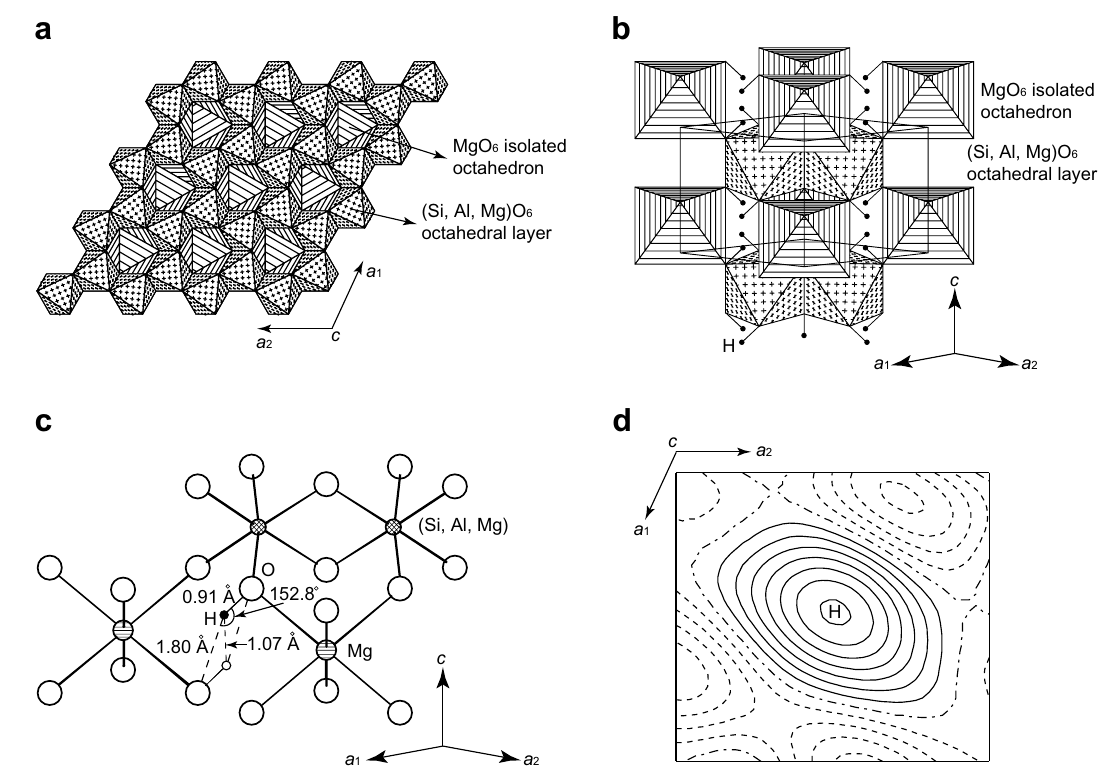
Figure 3. Crystal structure of the present Al-phase D, analyzed using a single-crystal produced in the run #3. ( a ) Projection along the c -axis (excluding H atoms). ( b ) Projection along the direction close to [110]. H site is denoted with small solid circles. In the present Al-phase D, H atoms occupy about 50% of this site. The crystal structure is based on the hexagonal closest packing array of O atoms and consists of the two types of octahedra, (Si, Al, Mg)O 6 -octahedra in S-site and MgO 6 -octahedra in M-site. The (Si, Al, Mg)O 6 -octahedra form the layer structure by sharing edges with each other, and the layers are stacked along the c -axis. The MgO 6 -octahedra, isolated with each other, connect the separations between the (Si, Al, Mg)O 6 -octahedral layers by sharing corners with the (Si, Al, Mg)O 6 -octahedra. The hydrogen bonds contribute to the linkages between the MgO 6 - octahedra and between the MgO 6 - and the (Si, Al, Mg)O 6 -octahedra. ( c ) Crystallographic configuration of H atom. The small solid circle is an occupied H-position, and the small open circle is an unoccupied H-position. ( d ) Difference Fourier map denoting the residual electron density peak assigned to a H atom. The contour interval is 0.05 eÅ −3 . Positive contours are solid lines. Negative and zero contours are dashed lines and dashed- and-dotted lines,